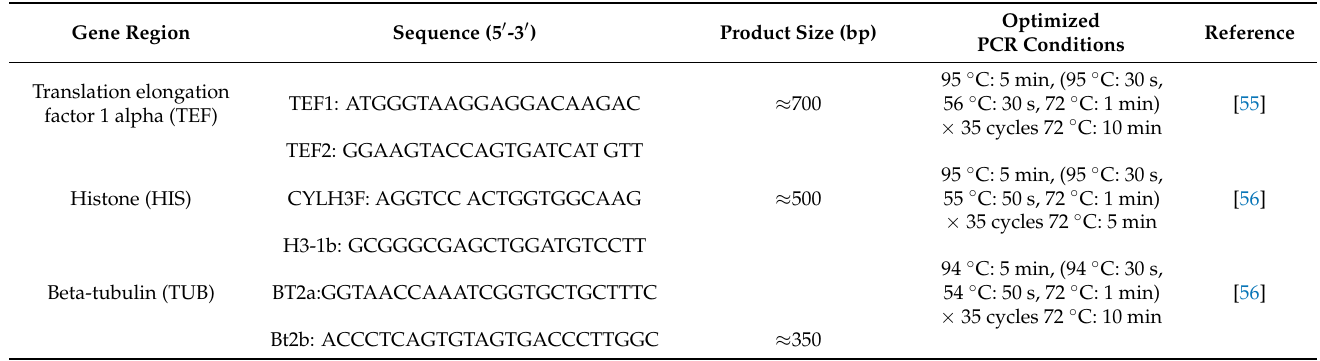
Table 2. Gene regions and primer pairs used in the current